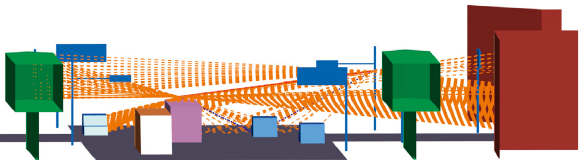
Figure 14: MPC spatial distribution in the vehicular channel in urban environments.